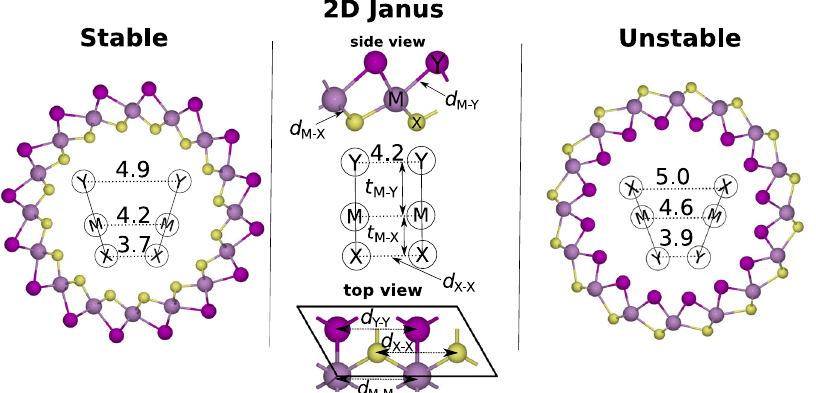
Fig. 6 Investigating inverse nanotube wrapping. Side (or cross-section) view for the energetically favored armchair BiSI nanotube, the in fi nite 2D Janus layer and the unstable inverse wrapped BiIS nanotube. Measures are given in Å